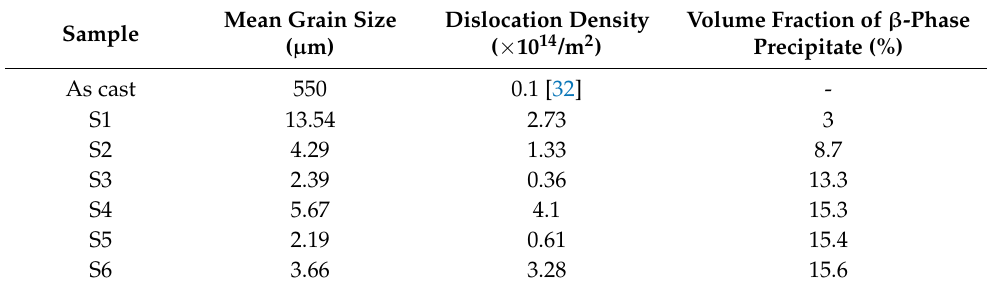
Table 3. Microstructure evolution for the TPCAE processed samples of AZ91 alloy via different processing routes